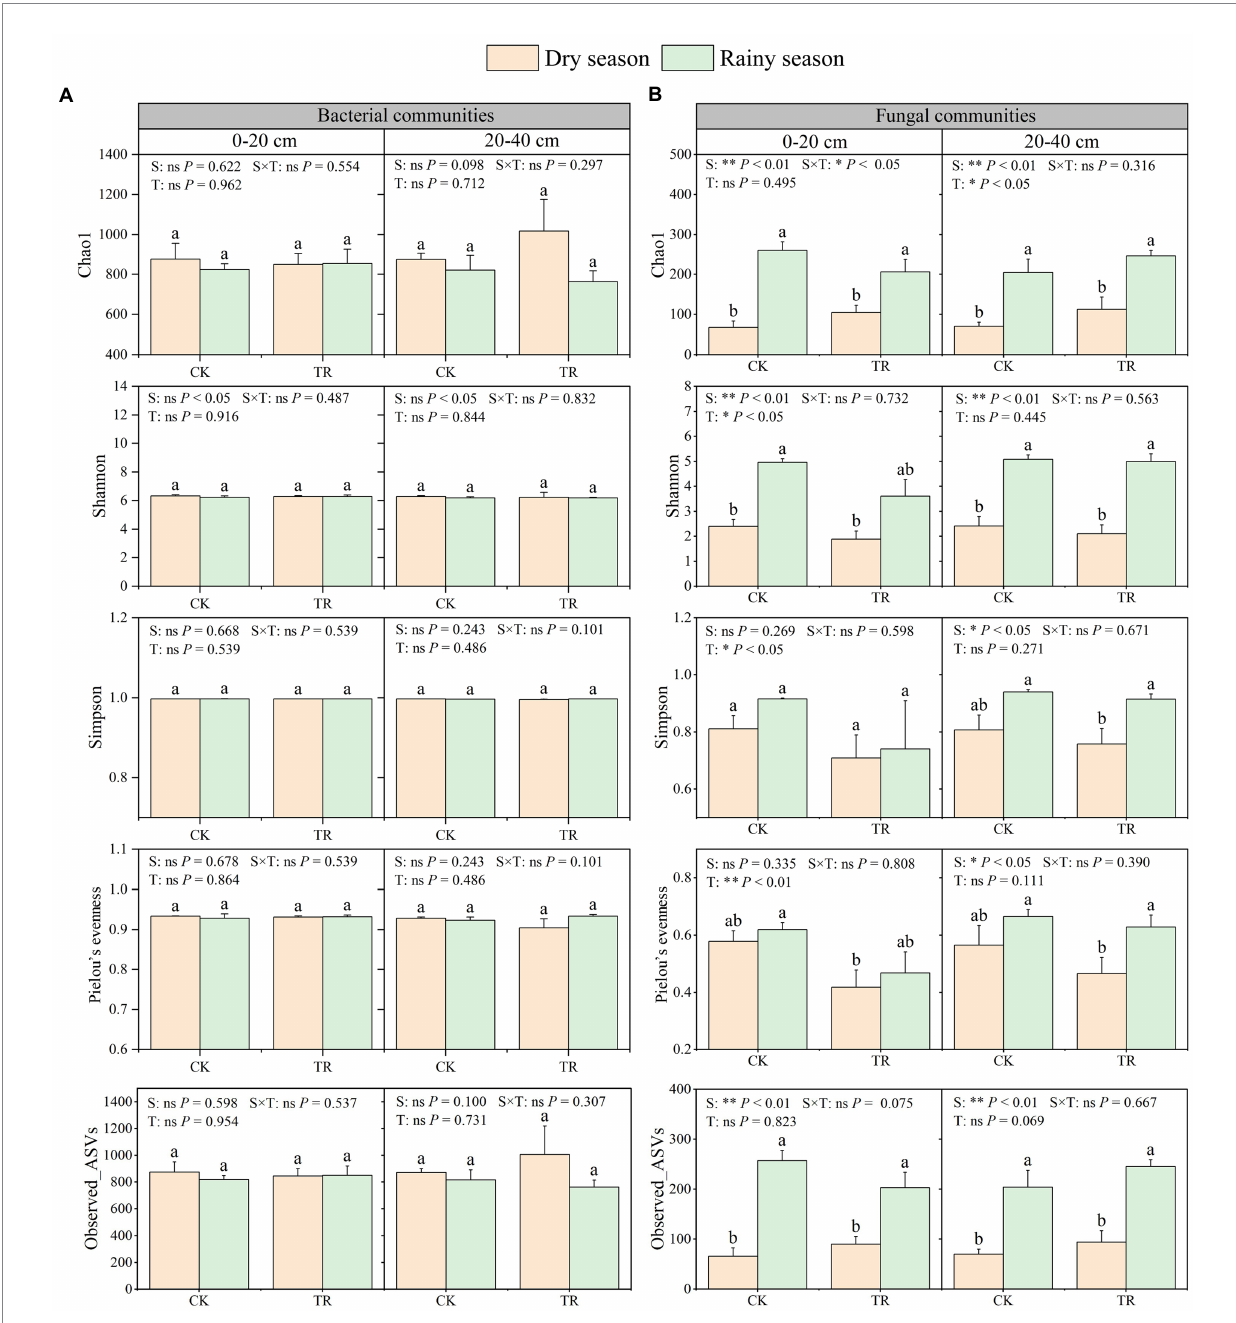
FIGURE 3 Alpha-diversity indices of bacterial (A) and fungal (B) communities in Eucalyptus plantations. Data are expressed as means + standard error ( n = 3). Statistically significant differences ( p < 0.05) between treatments are indicated by lowercase letters based on the Kruskal-Wallis test. CK, control; TR, throughfall reduction treatment. Data from GLM analyzes are indicated at the top of each graph; S, season, including dry season and rainy season; T, treatment, including TR and CK; S × T, the interaction of season and treatment; ‘*’, ‘**’, and ‘ns’ refer to p < 0.05, p < 0.01, and p > 0.05, respectively. Block design was added to the GLM analysis as a